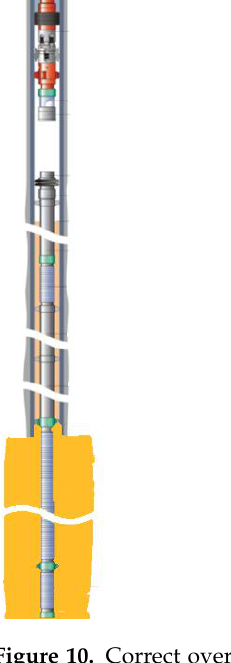
Figure 10. Correct overhead technical equipment of a gas well at its mouth, (source: elaborated by authors). Each gas well shall be subject to a so-called underground repair of the well after a certain period of operation or on the basis of its actual technical condition and production in order to continue to operate safely. Electronic records of its technical condition will also contribute to this. The benefit of our algorithm and the work progress is to create fast and transparent monitoring of wells (i.e., well records and information about wells). Thus, the result of the formed program is the recording of wells, where the user can find his or her sought-after well by name. Alternatively, through the legend on the right side of the screen, the user can choose what hydrocarbon deposits he or she is interested in and click on the type of well he or she wants to be displayed in those hydrocarbon